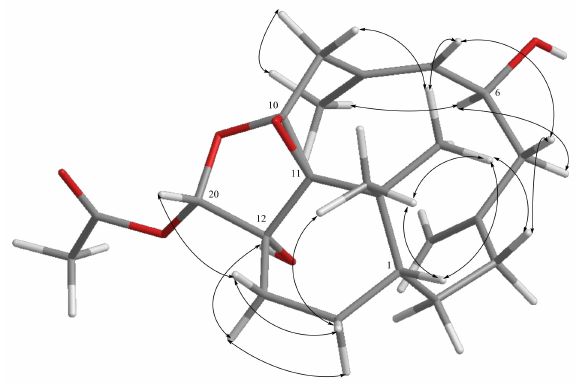
Figure 5. Selected COSY and HMBC correlations of 8 – 16 .